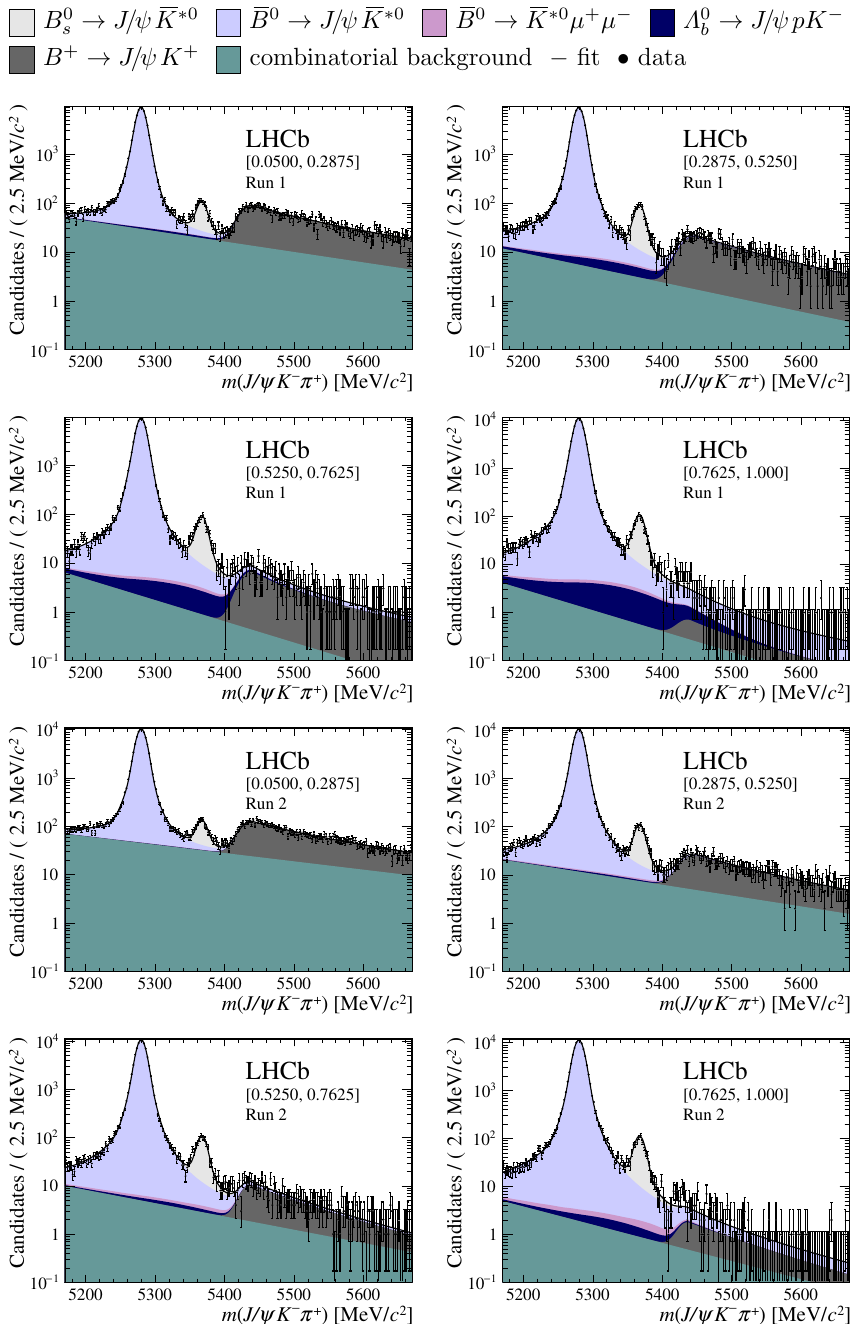
Figure 6 . Distribution of reconstructed J= K (cid:0) (cid:25) + invariant mass after application of a J= mass constraint of candidates in (top four (cid:12)gures) the Run 1 and (bottom four (cid:12)gures) Run 2 data sets. The candidates are divided into four independent bins of increasing neural network response per data taking period.